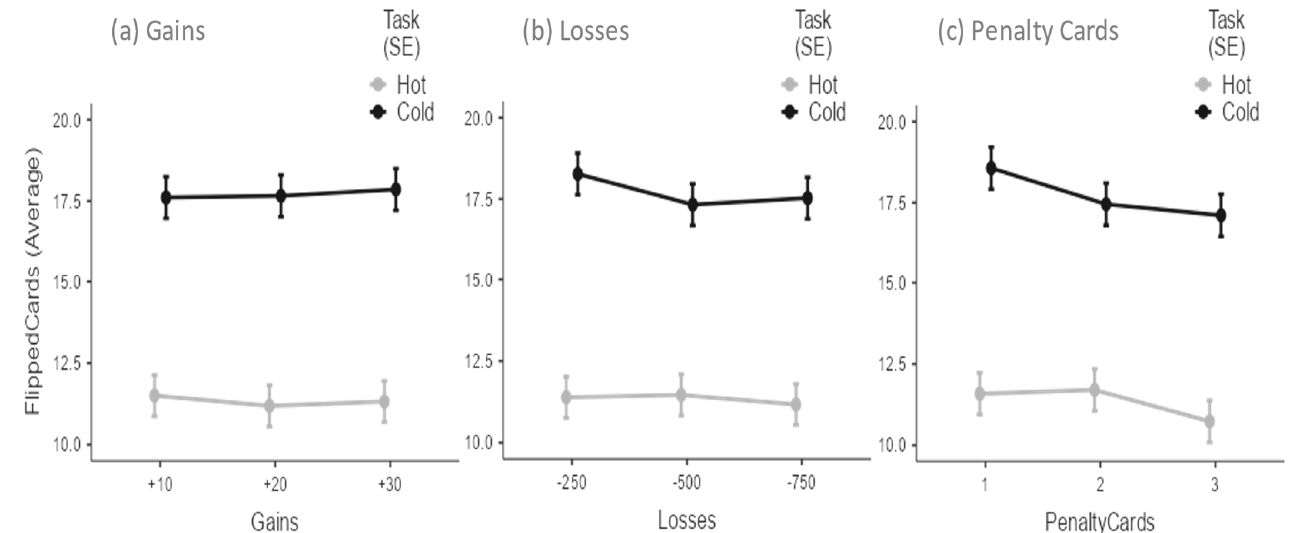
Figure 1. Average number of flipped cards per trial in the Hot and Cold Columbia Card Task as a function of ( a ) potential gains, ( b ) potential losses, and ( c ) penalty cards.